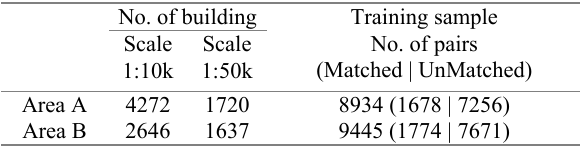
Table 1: Overview of topographic data and training samples